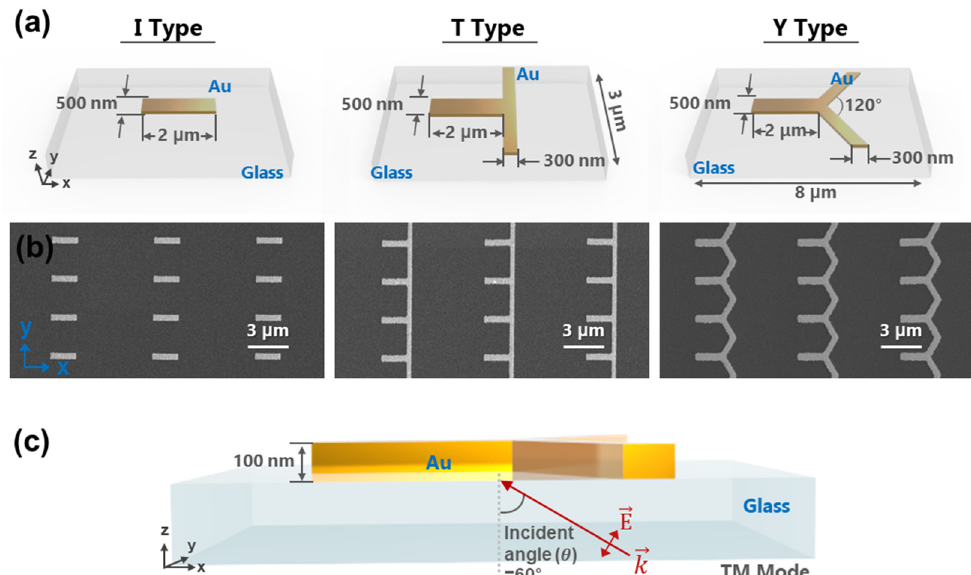
Figure 1. ( a ) Schematics and specifications of I-, T-, and Y-shaped gold nanostructures applied in numerical simulations of plasmonic fields. The period of each nanostructure was 3- µ m long and 8- µ m wide. ( b ) SEM images of I-, T-, and Y-shaped nanostructures fabricated by electron-beam lithography to validate that each nanostructure can be established. ( c ) Schematic of simulation conditions under which light enters the nanostructures. The thickness of each nanostructure was 100 nm.